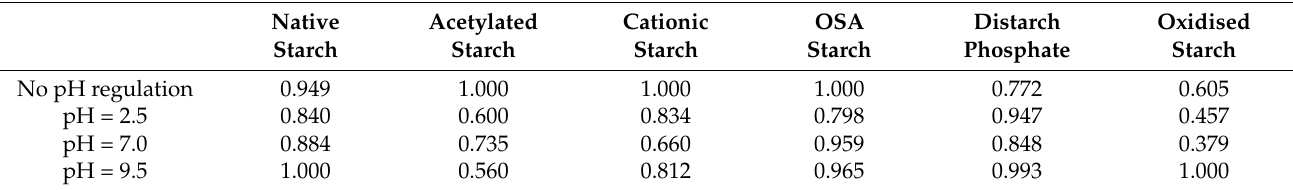
Table 7. Mean polydispersity index (PdI) recorded in the analysed starch